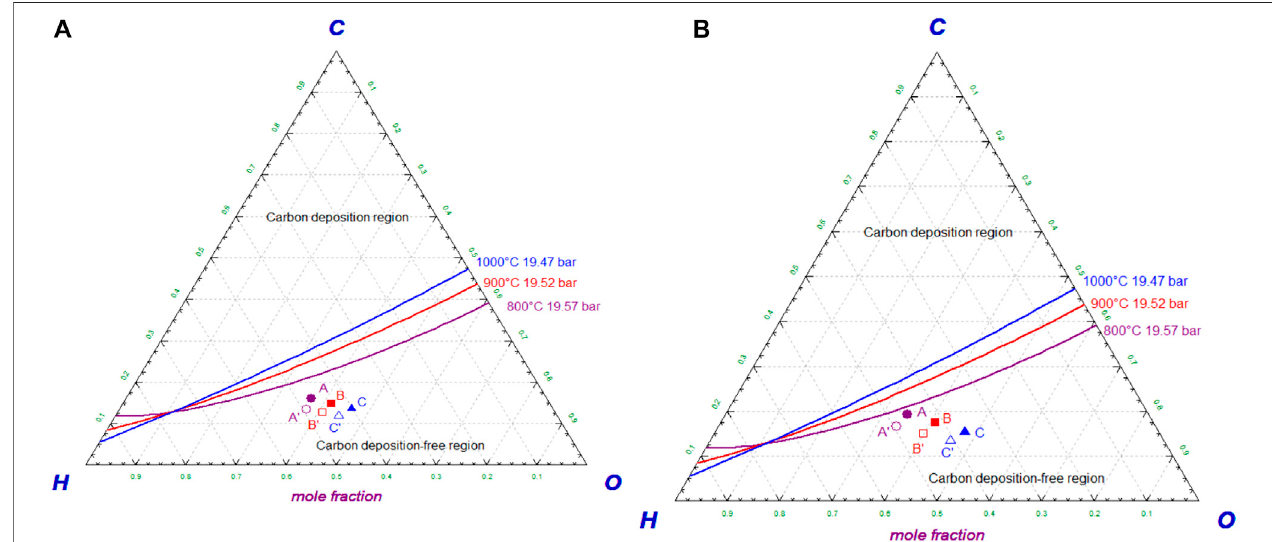
FIGURE 3 | (A) C-H-O ternary phase diagram showing equilibrium curves and operating conditions of the SOFC for the air gasi fi cation case. (B) C-H-O ternary phase diagram showing equilibrium curves and operating conditions of the SOFC for the steam-oxygen gasi fi cation case.